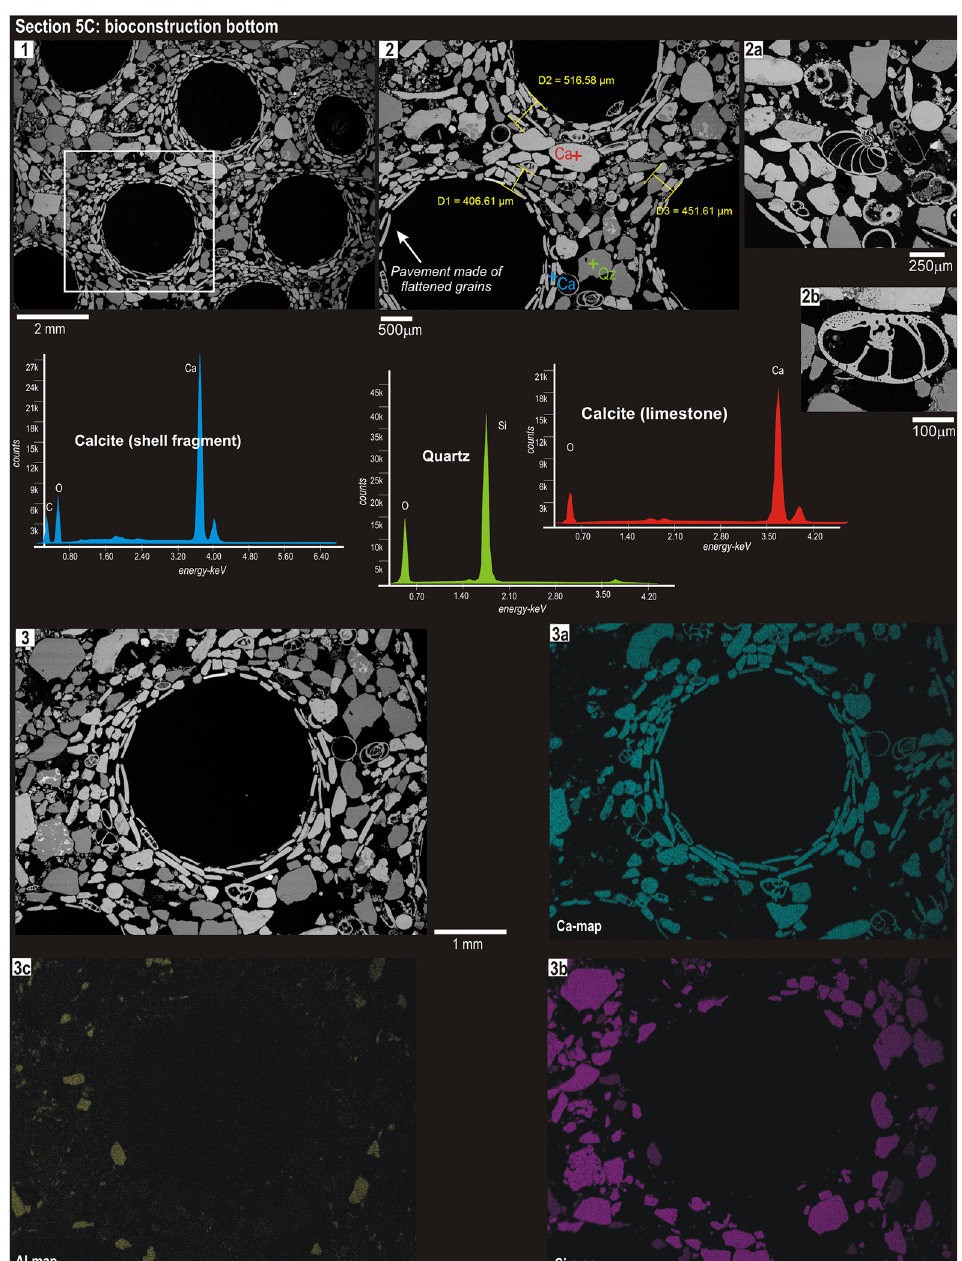
Fig 2. Back-scattered electron (BSE) image of aggregated tubes (the same of Fig 1; photo 1) horizontally sectioned at the bottom. The coloured crosses indicate the spots for standardless microanalyses; the corresponding EDS spectra as well as the elemental maps (silicon-Si in violet, aluminium-Al in yellow and calcium-Ca in light blue) are reported below.